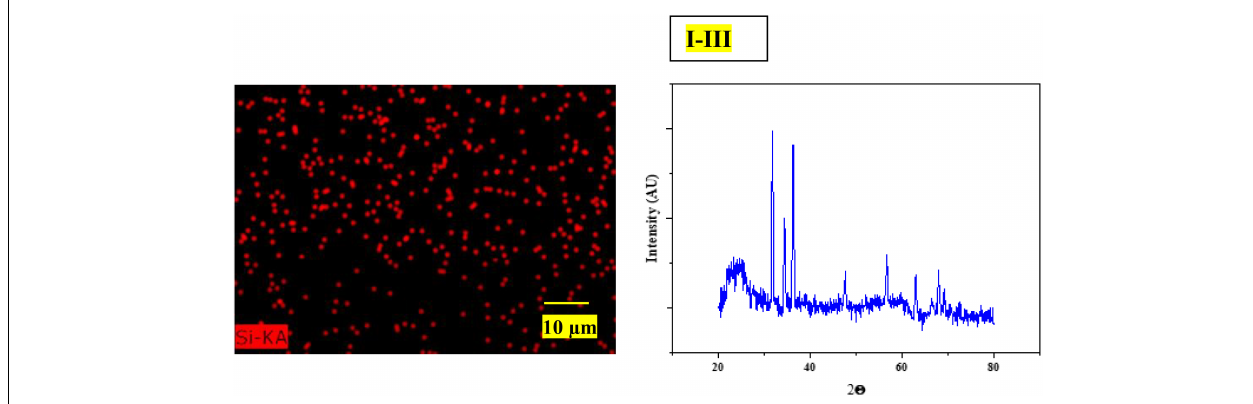
FIGURE 1 | Micrographs of TiO 2 particles; (1a) SEM of microparticles and (1b) TEM of nanoparticles; 1-II – SEM and EDAX micrographs of representative composites showing uniform distribution of filler particles; 1-III – X-ray diffraction pattern for nano-TiO 2 particles.